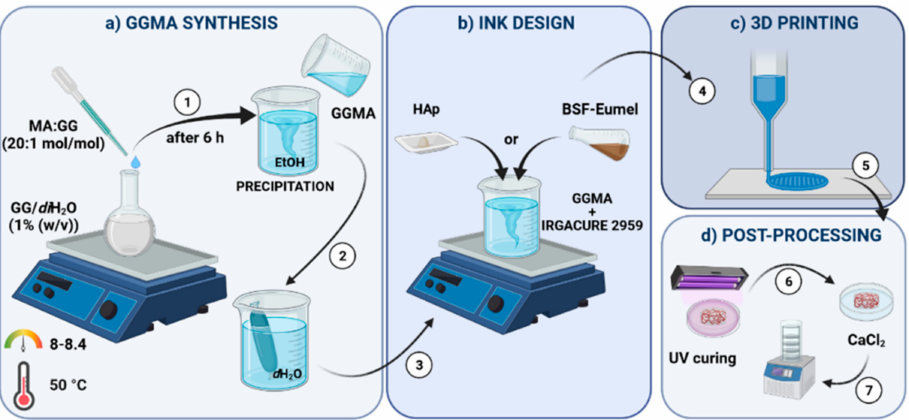
Figure 1. Schematic representation of the multi-step methodology adopted for the bioactivated methacrylated gellan gum (GGMA)-based scaffold fabrication by 3D printing. The